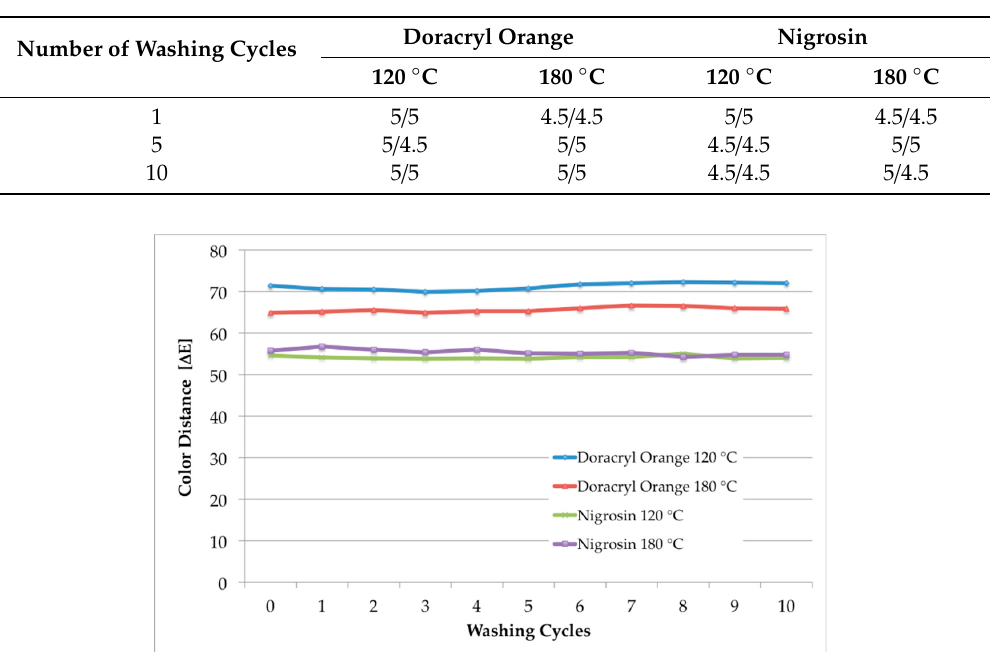
Table 4. Fastness to light of amorphous m-aramid fabrics dyed in EMIM-EtSO 4 with Doracryl Orange and Nigrosin at 120 °C and 180 ° C, respectively. Dyestuff